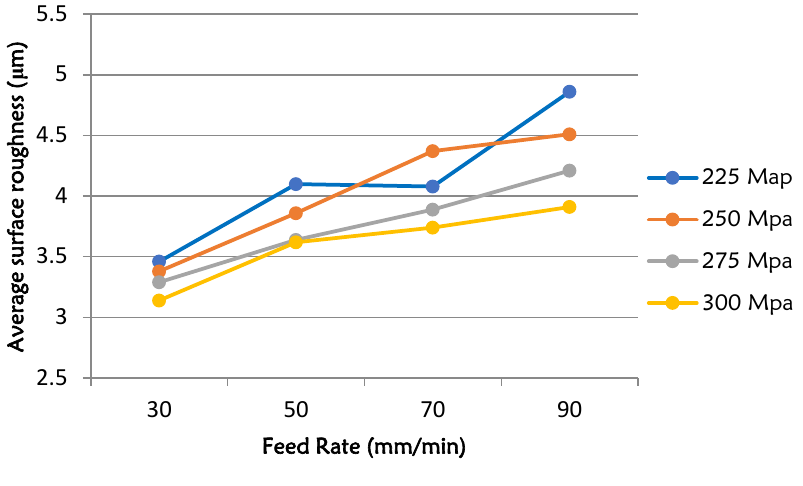
Figure 9: A plot of impact of feed rate on the average surface roughness (Ra).